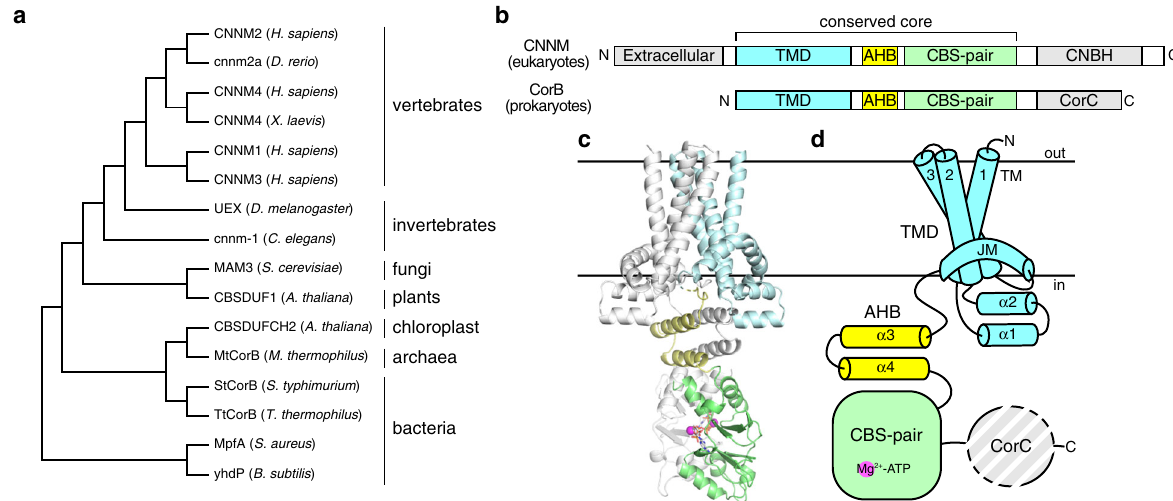
Fig. 1 Overall structure and domain organization of CNNM/CorB Mg 2 + transporters. a Phylogenetic analysis of representative CNNM/CorB orthologs generated using the neighbor-joining method. b Domain organization of eukaryotic CNNM and prokaryotic CorB. TMD transmembrane domain, AHB acidic helical bundle, CNBH cyclic nucleotide-binding homology domain, CorC cobalt resistance C domain. c Crystal structure of the Mg 2 + -ATP-bound MtCorB without the C-terminal CorC domain as a homodimer. One chain is colored by domains. d Topology of a MtCorB monomer showing the transmembrane and juxtamembrane helices of the TMD (residues 1 – 154, cyan ), the two helices of the AHB (residues 166 – 199, yellow ), the Mg 2 + -ATP-binding CBS-pair domain (residues 200 – 324, green ), and the CorC domain (residues 325 – 426, grey